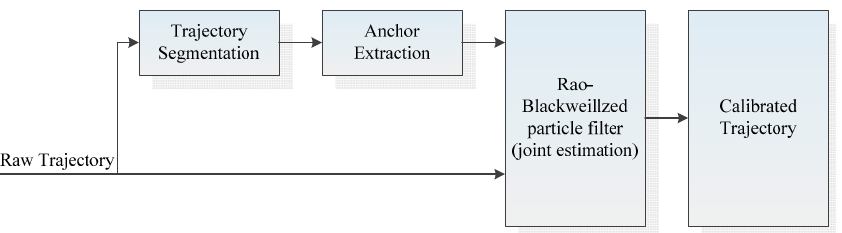
Figure 1. Overall framework of the proposed method.